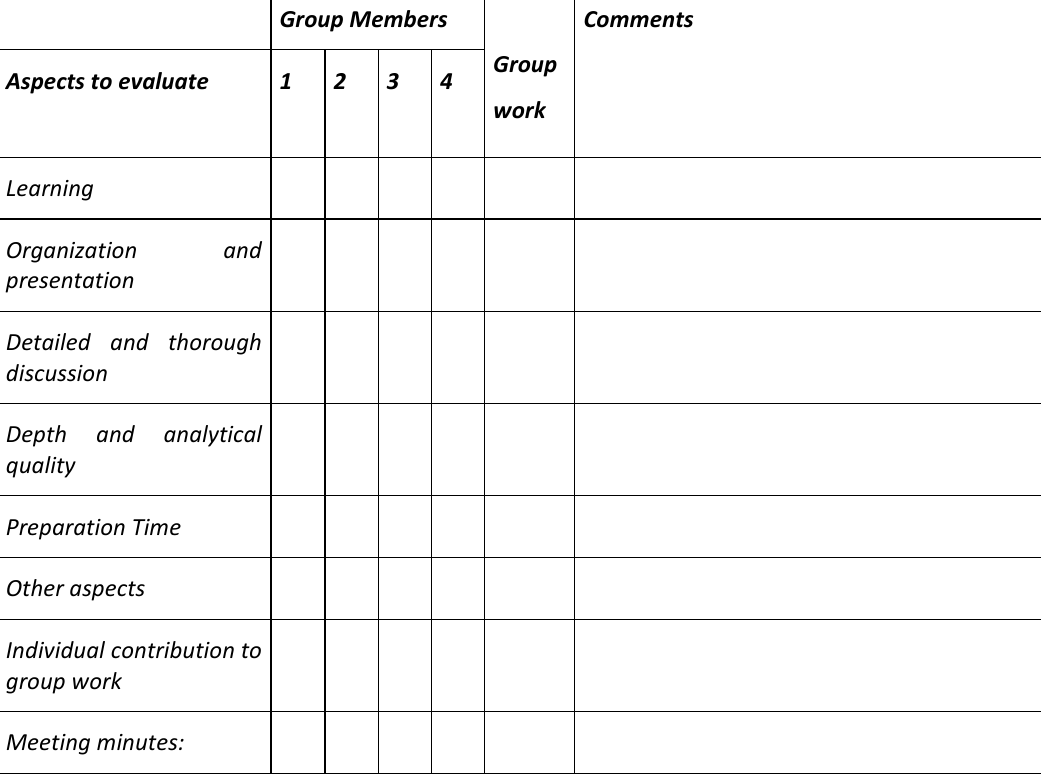
Table 3 – Group self-assignment report of practical